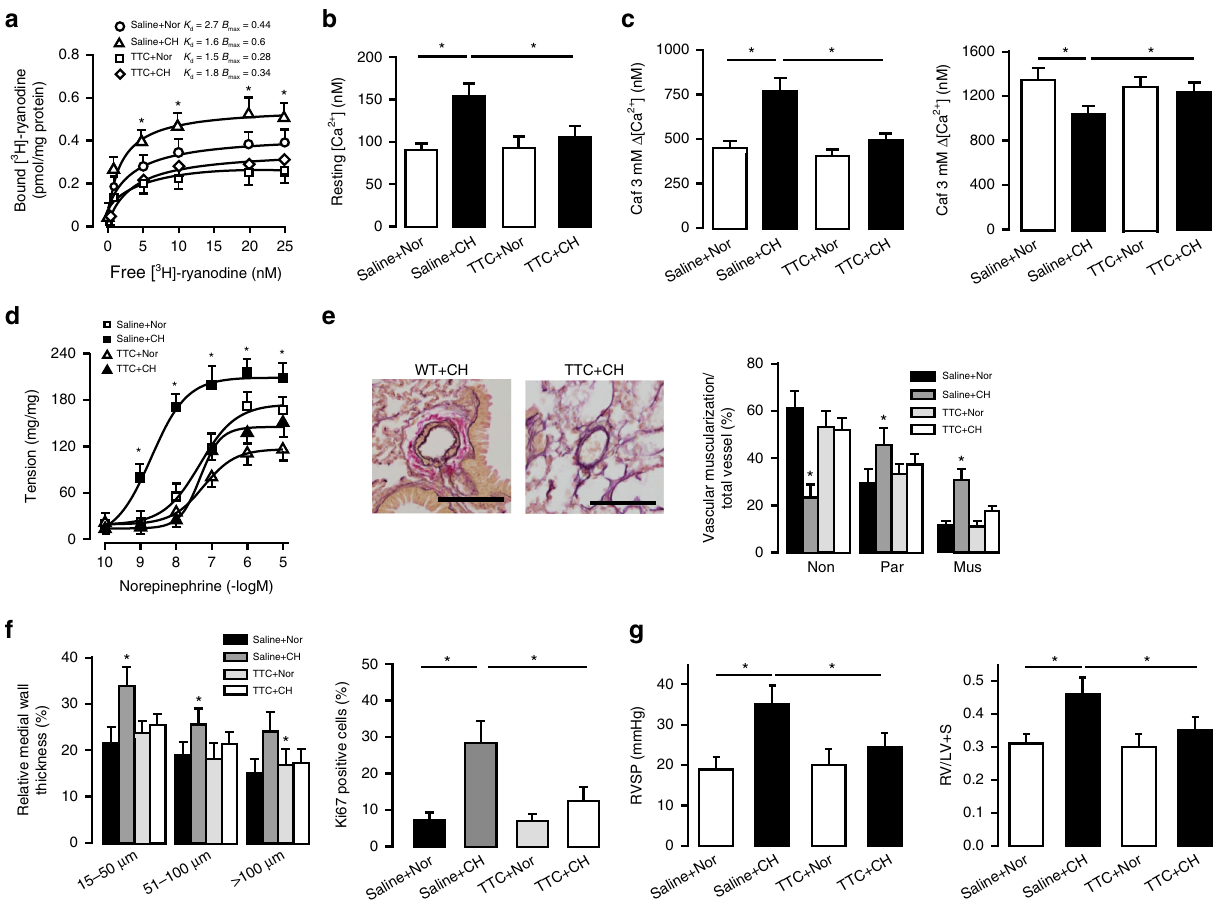
Fig. 3 Inhibition of RyR2 confers similar protective effect as RyR2 KO in CH-induced PH. a Determination of RyRs activity by [ 3 H]-ryanodine binding assays are conducted from PAs from TTC treatment group ( n = 5 independent studies, 5 mice per study). b Summary of elevated PASMC resting [Ca 2 + ] i level after exposure to 3 weeks CH in administration of TTC. PASMC are loaded with fura-2/AM (5 µ M) ( n = 5 independent studies, 60 cells per study). c Bar graph s ummary of medium (3 mM) and maximal (30 mM) dosage of caffeine (Caf) -induced Ca 2 + peak in TTC treatment group ( n = 5 independent studies, 60 cells per study). d Pulmonary arterial contractility measured by concentration-response curve induced by norepinephrine, which obtained from TTC treated PA strips ( n = 4 independent studies, 6 PA strips per study). e Typical lung sections of PAs from WT mice administrated by TTC (bar scale: 50 µ m). Proportion of non-(Non), partially (Par), or fully (Mus) muscularized PAs in total counted PAs (n = 5 independent studies, 60 vessels per study). f Medial wall thickness of PAs sized 15 – 50, 51 – 100, and over 100 μ m in relation to cross-sectional diameter ( n = 5 independent studies, 60 vessels per study). PASMC proliferation (Ki-67 staining) in vivo after 3 weeks hypoxic condition ( n = 5 – 7, 50 – 60 vessels per group). g Summarized the effect of CH or Nor on RVSP in saline (control) and tetracaine (TTC, 2 mg/kg/d) treatment group mice model, measured by 1.2F catheter. RV/LV + S to measure RV hypertrophy ( n = 6 independent studies, 5 mice per study). Data are expressed as mean ± standard error. (* P < 0.05, using one-way